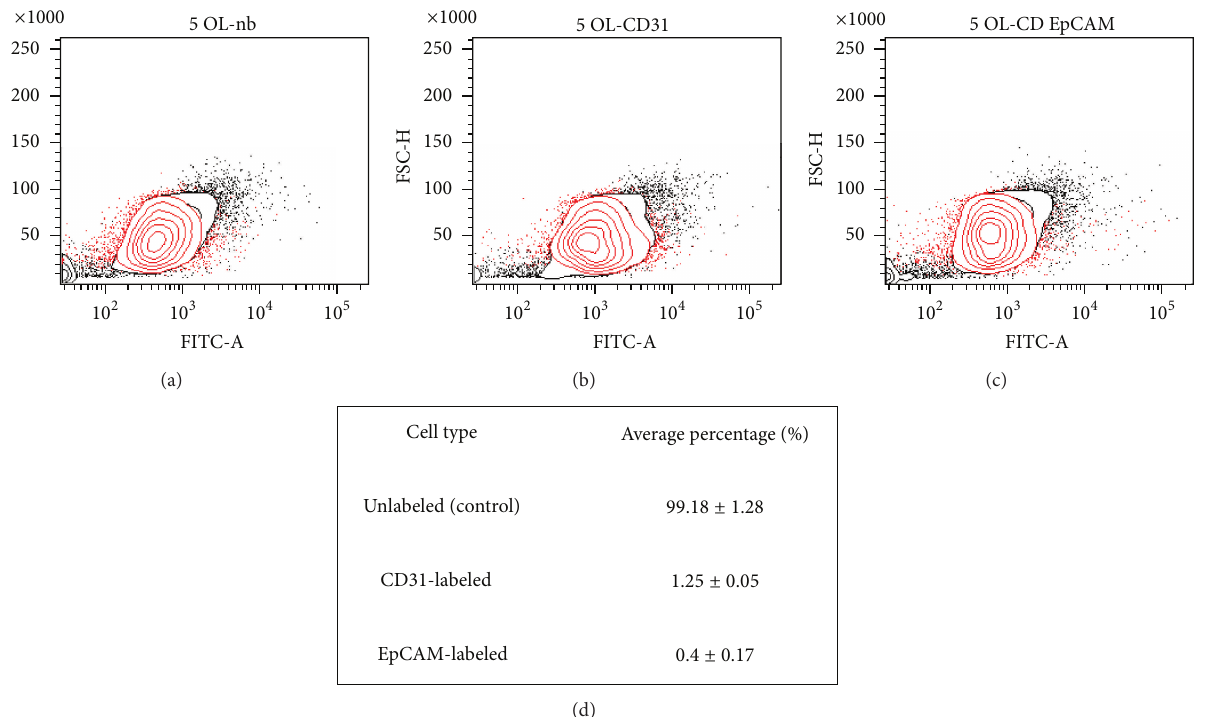
Figure 2: Representative flow cytometric plots of human endometrial cells, at 1st passage (day 1 after isolation). (a) Unlabeled cells. The contour plot shows the unstained population of cells. (b) Population of CD31 (EpCAM-1) stained cells, marker of endothelial cells. (c) Population of CD326 (EpCAM) stained cells, marker of epithelial cells. Data were elaborated with BD FACSAria II Software. (d) Table of the expression of the cell types expressed as average percentage ± SD of 3 endometrial specimens.